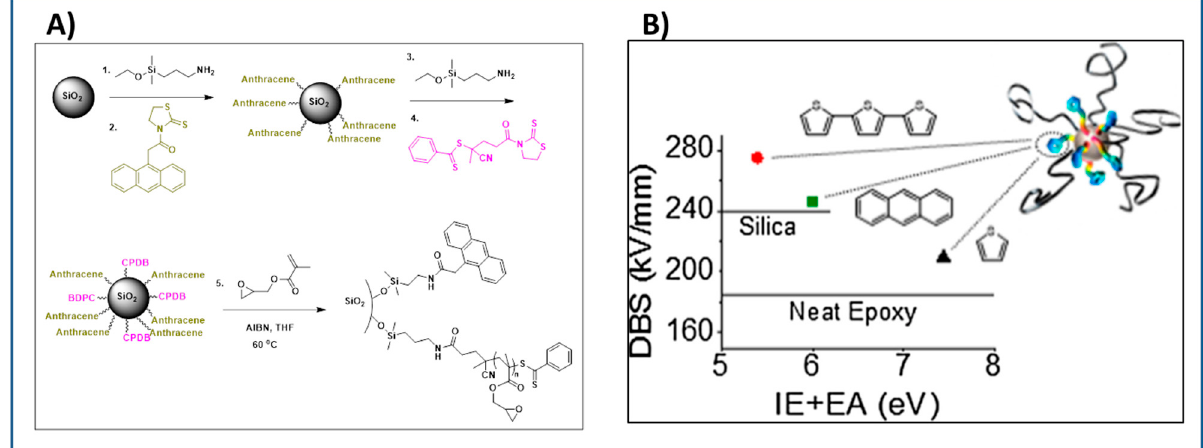
Figure 12. ( A ) Synthesis of bimodal anthracene-PGMA silica nanoparticles ( B ) calculated summation of ionization energy and electron affinity for electroactive ligands V·s. experimentally determined dielectric breakdown strength of several bimodal composites. Reproduced with permission from Ref [187].